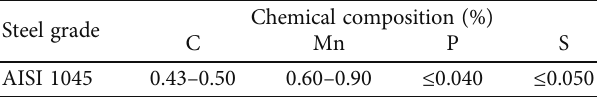
Table 1: Chemical composition of AISI 1045.